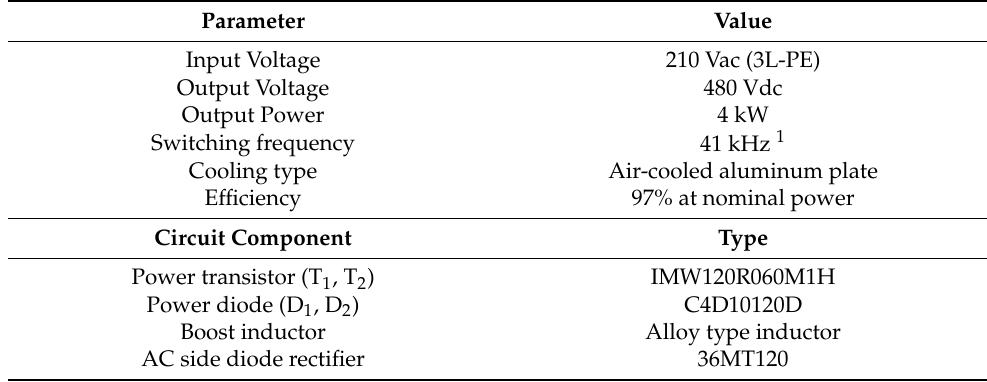
Table 2. Main input-to-output operational parameters of non-optimized three-phase PFC circuit and circuit components specification.